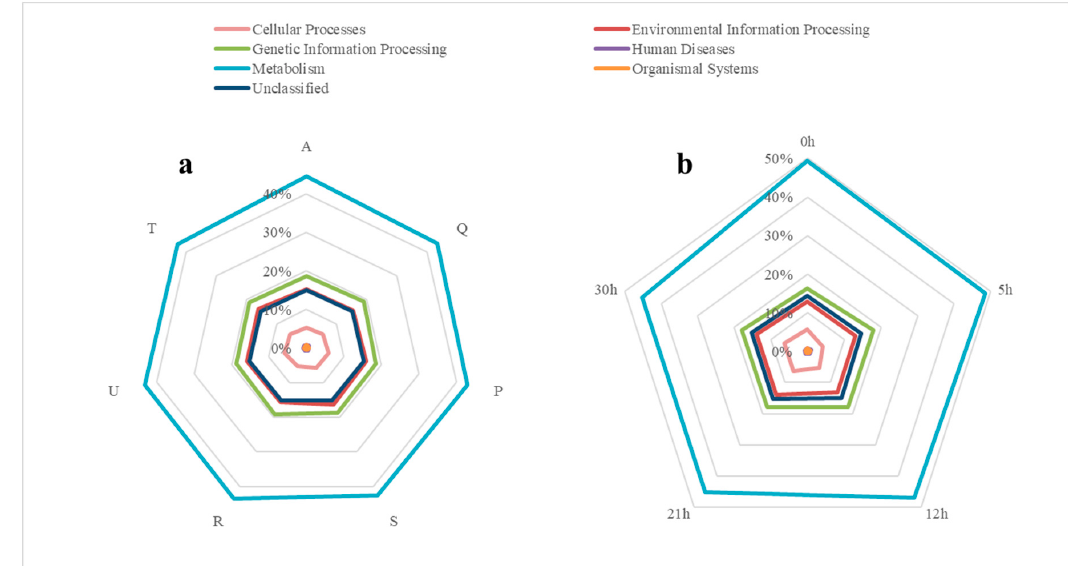
Figure 9. Bacterial functions analysis. ( a ) Distributions of bacterial functions at the top level of pathways modules in di ff erent antibiotic-treated groups; ( b ) distributions of bacterial functions at the top level of pathways modules in the groups of di ff erent enrichment time. GIP—genetic information processing; EIP—environmental information processing; CP—cellular processes.